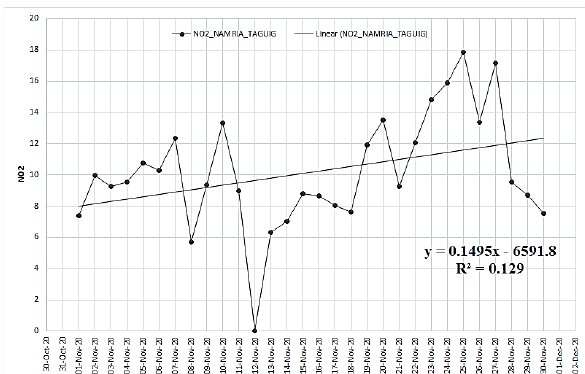
Figure 14. Ground-based observations of NO 2 levels at NAMRIA station on 03/01 to 03/31,